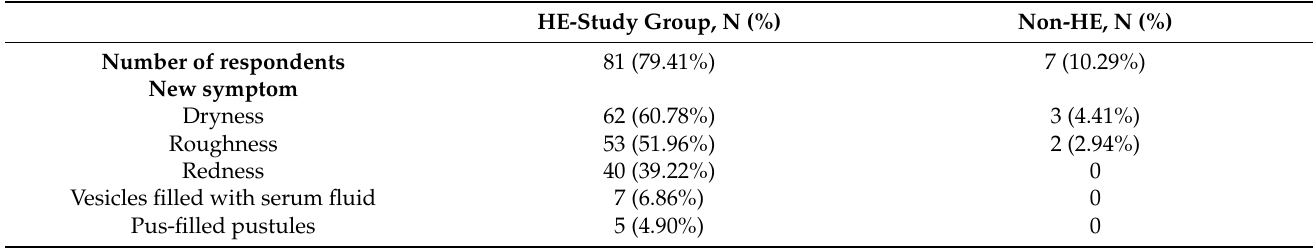
Table 3. The frequency of new symptoms reported by respondents in both groups (HE-study group vs. non-HE). HE-Study Group, N (%) Non-HE, N (%) 81 (79.41%) 7